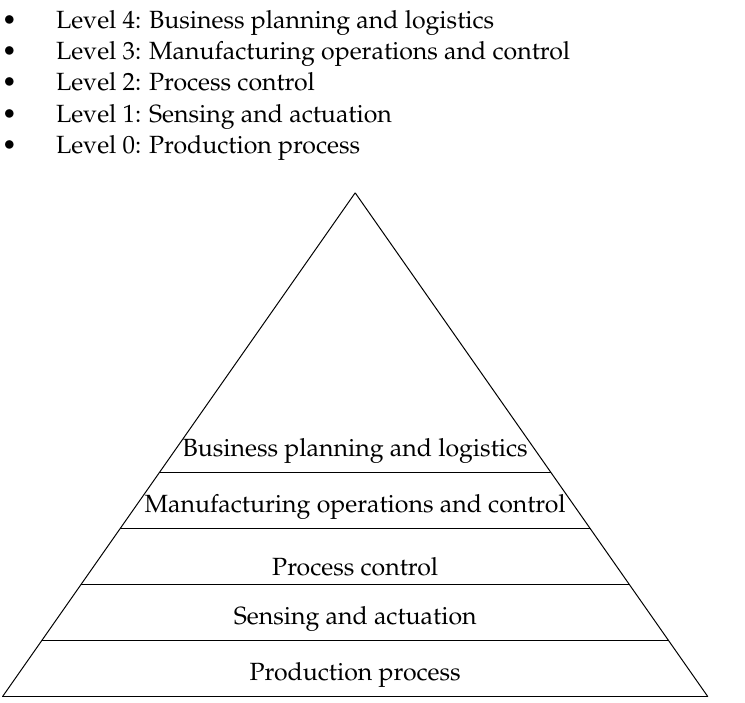
Figure 3. The five levels of the automation pyramid based on